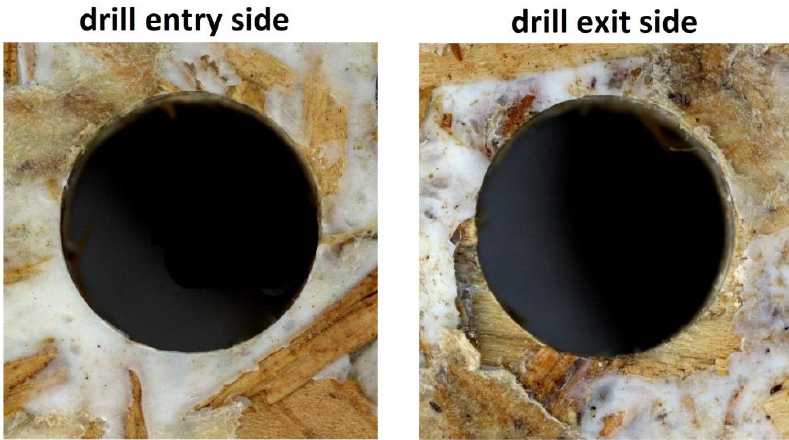
Figure 2. Sample photos of the hole taken on both sides of the particleboard.